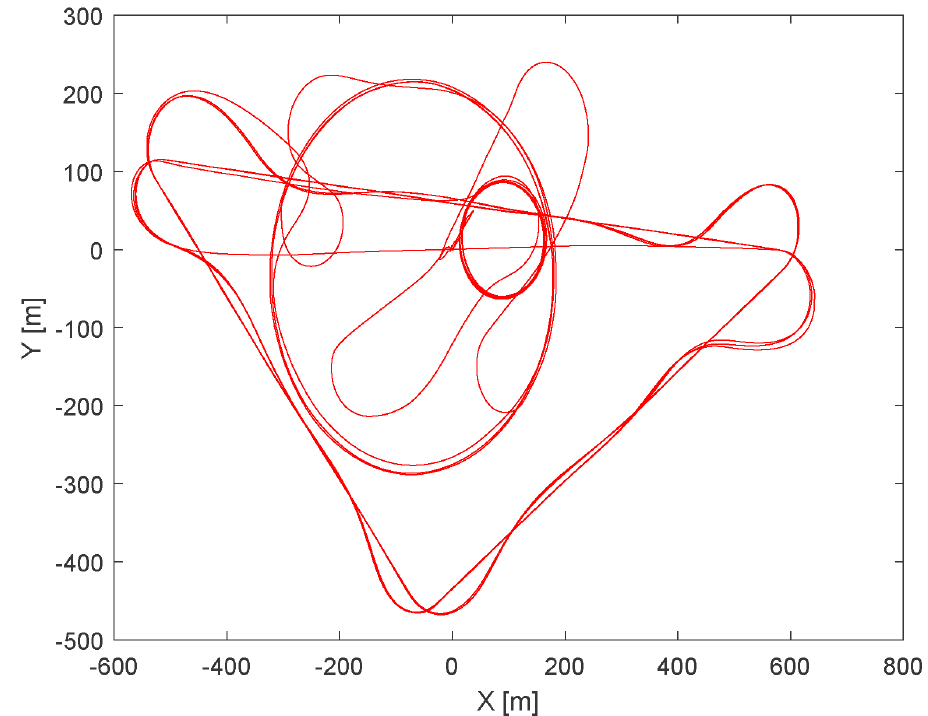
Figure 14. Flight trajectory top view.